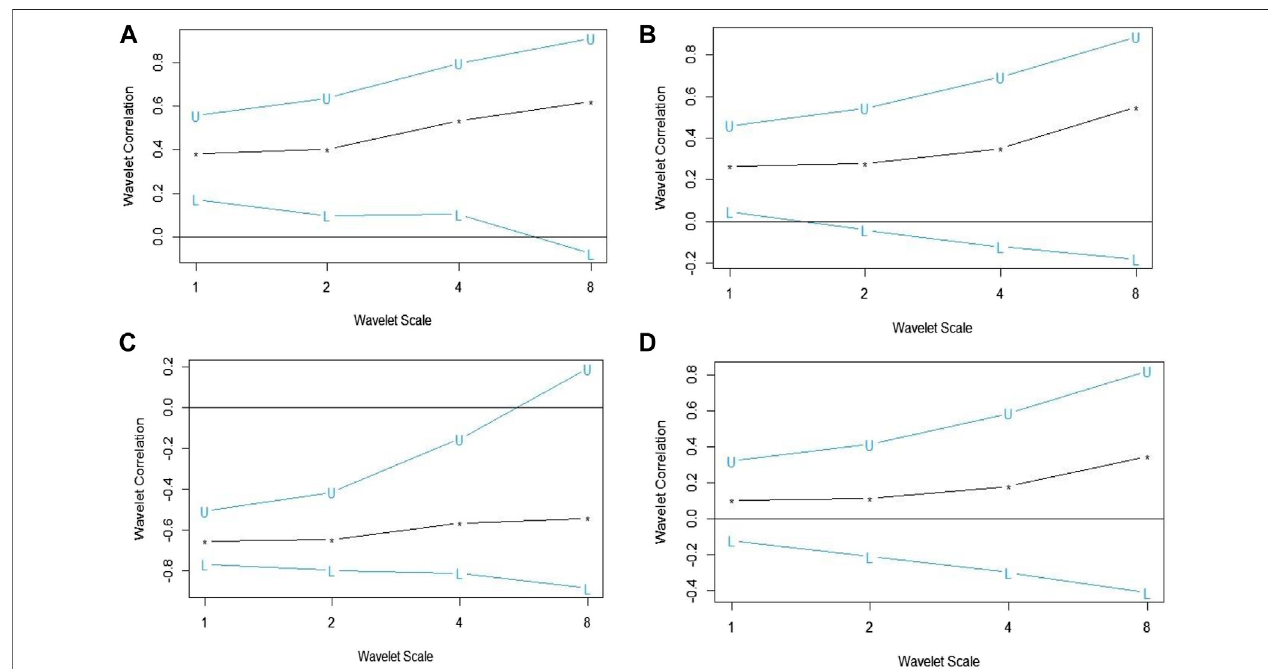
Frontiers in Environmental Science |